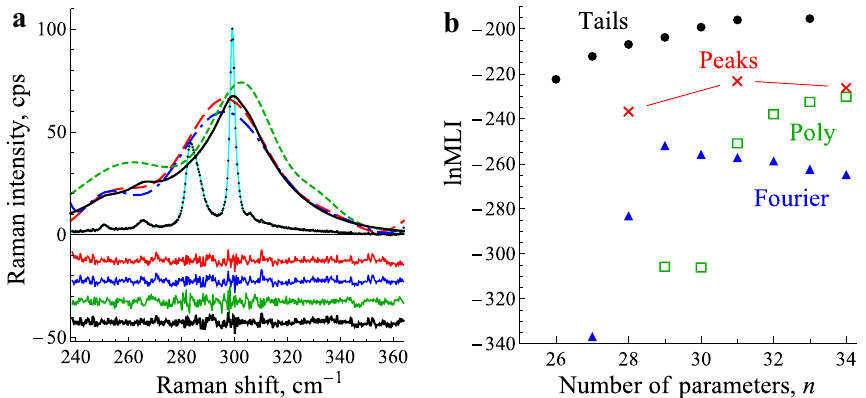
Figure 3. Carbon nanotube Raman spectrum. In ( a ), the carbon nanotube Raman spectrum is plotted (black datapoints) with a fit (cyan solid line) using the Fourier model. The residuals for four good fits are shown, × 10 and displaced successively downwards (Fourier, Polynomial, Peaks and Tails; all at ln L about − 60, see text). The backgrounds are shown, × 8 (long dashed, chain-dotted, short dashed and solid, respectively. In ( b ),